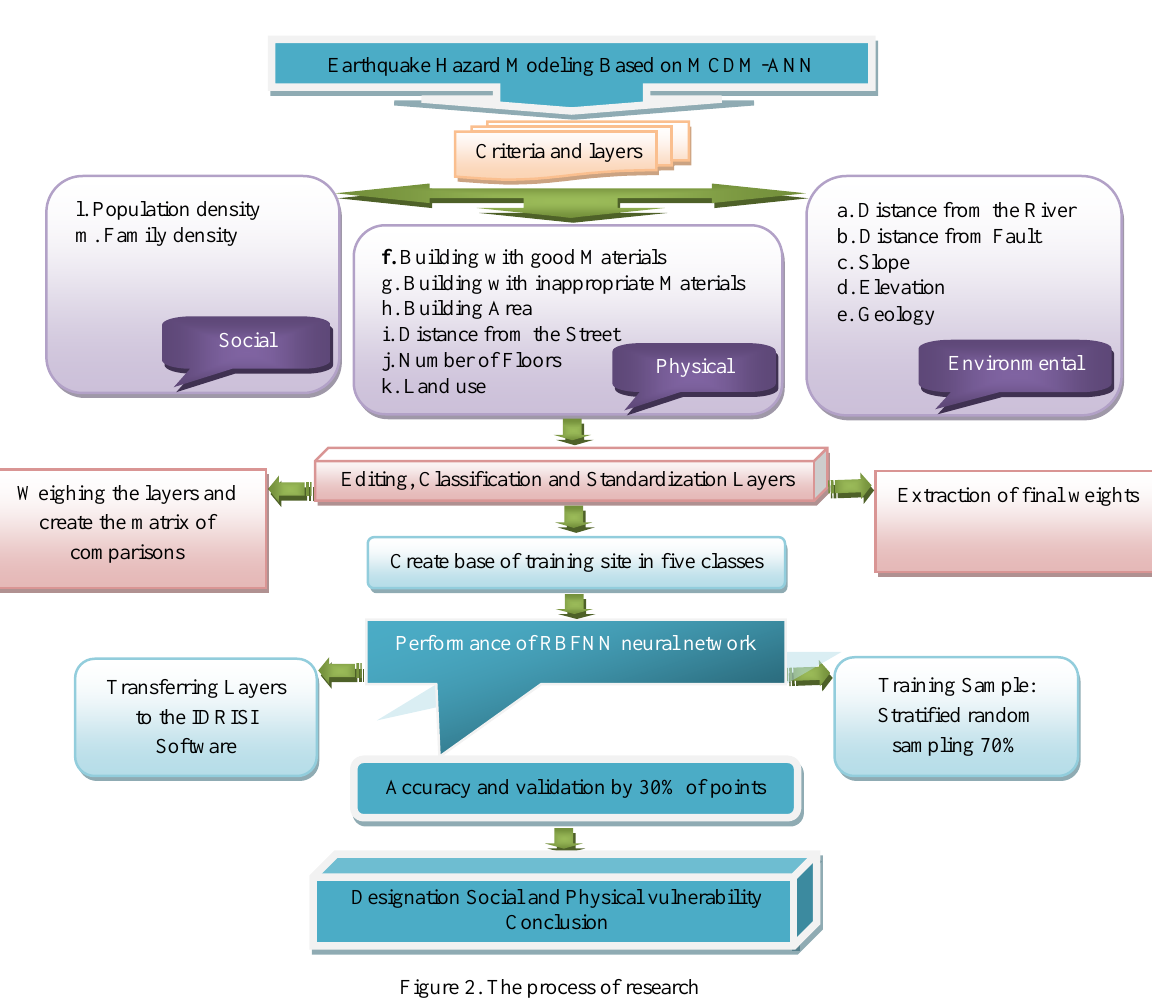
Figure 2. The process of